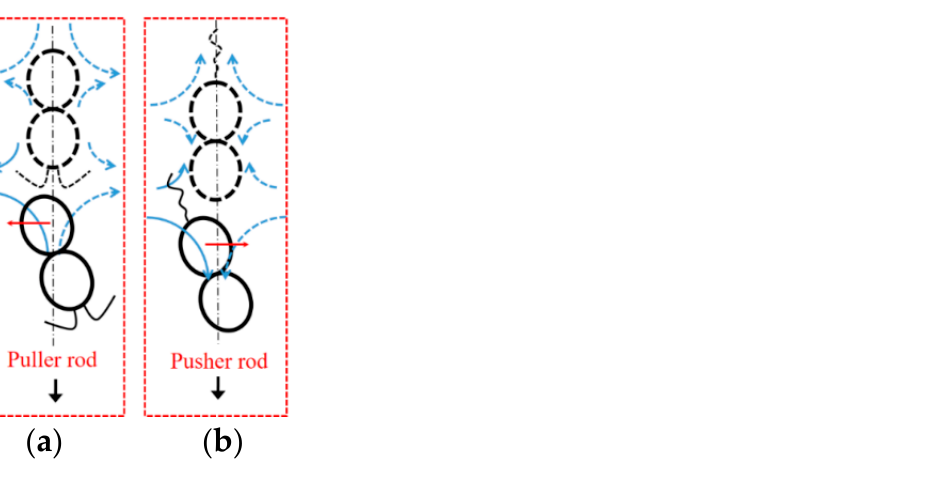
squirmer was relatively stable, it also rotated continuously.